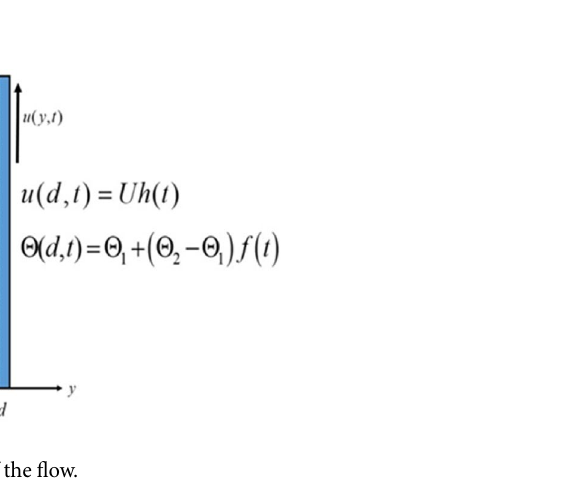
Figure 1. Schematic diagram of the